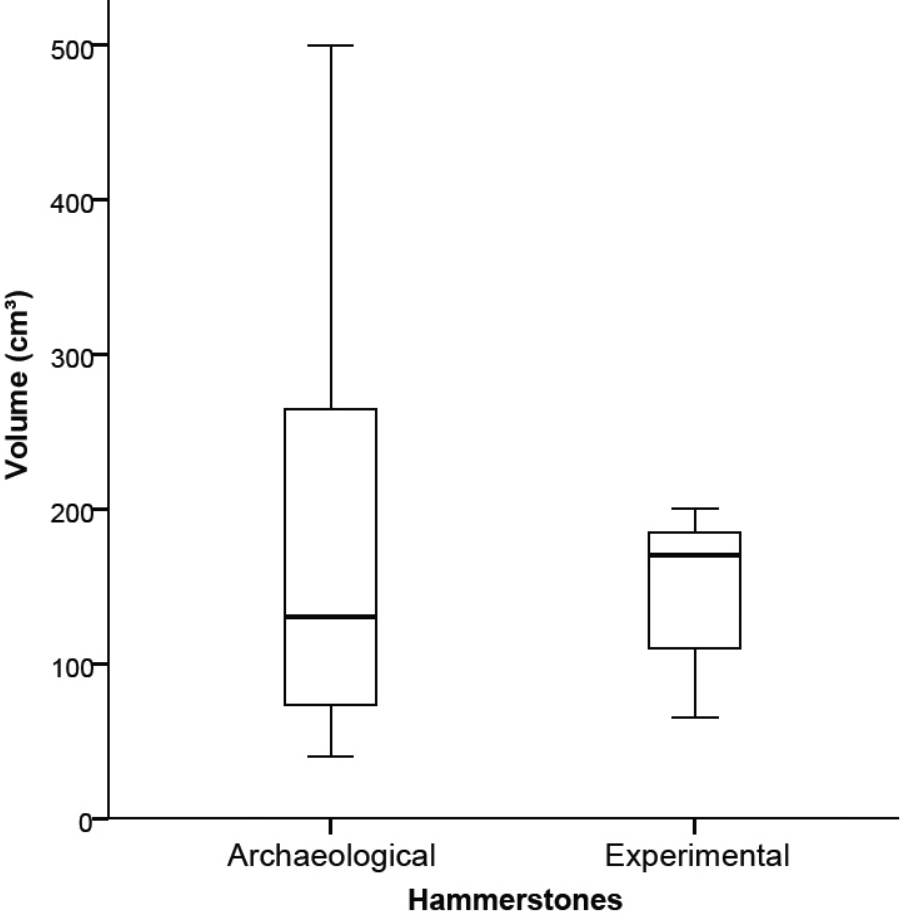
Figure 10. Box plot of experimental and archaeological